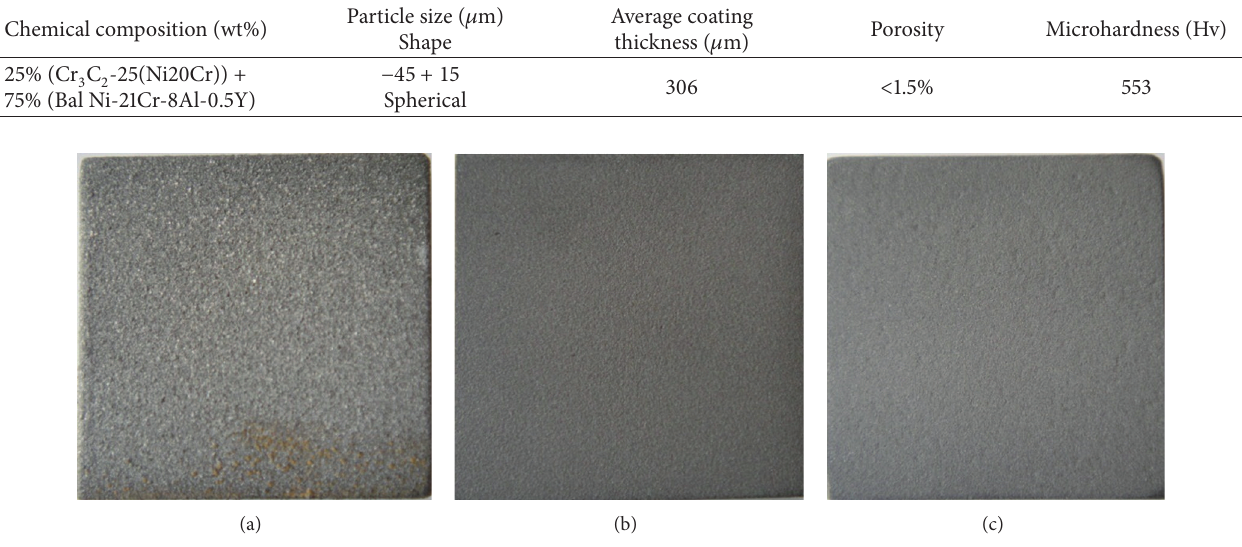
Figure 2: Optical macrograph of 25% (Cr 3 C 2 -25(Ni20Cr)) + NiCrAlY coated materials. (a) Ti-31, (b) Superco-605, and (c) MDN-121. Dimension of the samples: 25mm × 25 mm.